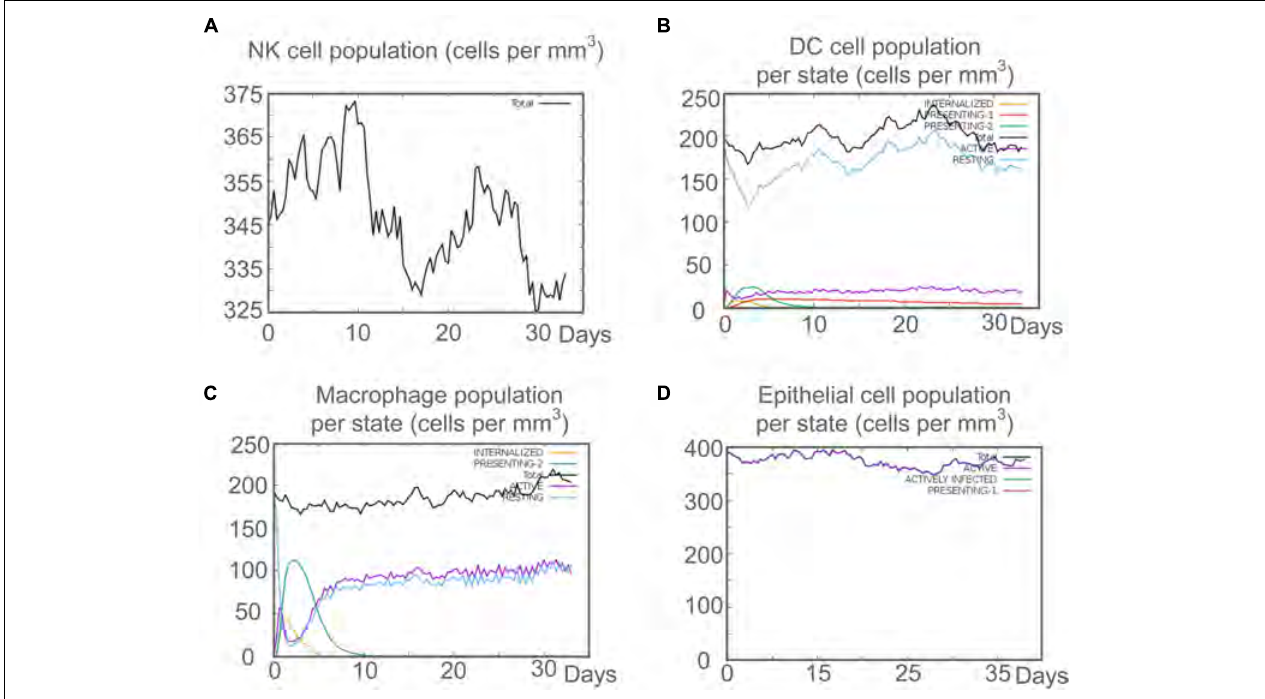
FIGURE 9 | The innate immune responses induced by C543P in C-ImmSim server. (A) Expression of NK cells after antigen stimulation. (B) Expression of DC cells (black) after antigen stimulation. (C) Expression in macrophages (black) after antigen stimulation. (D) Secretion from active epithelial cells (purple) after antigen